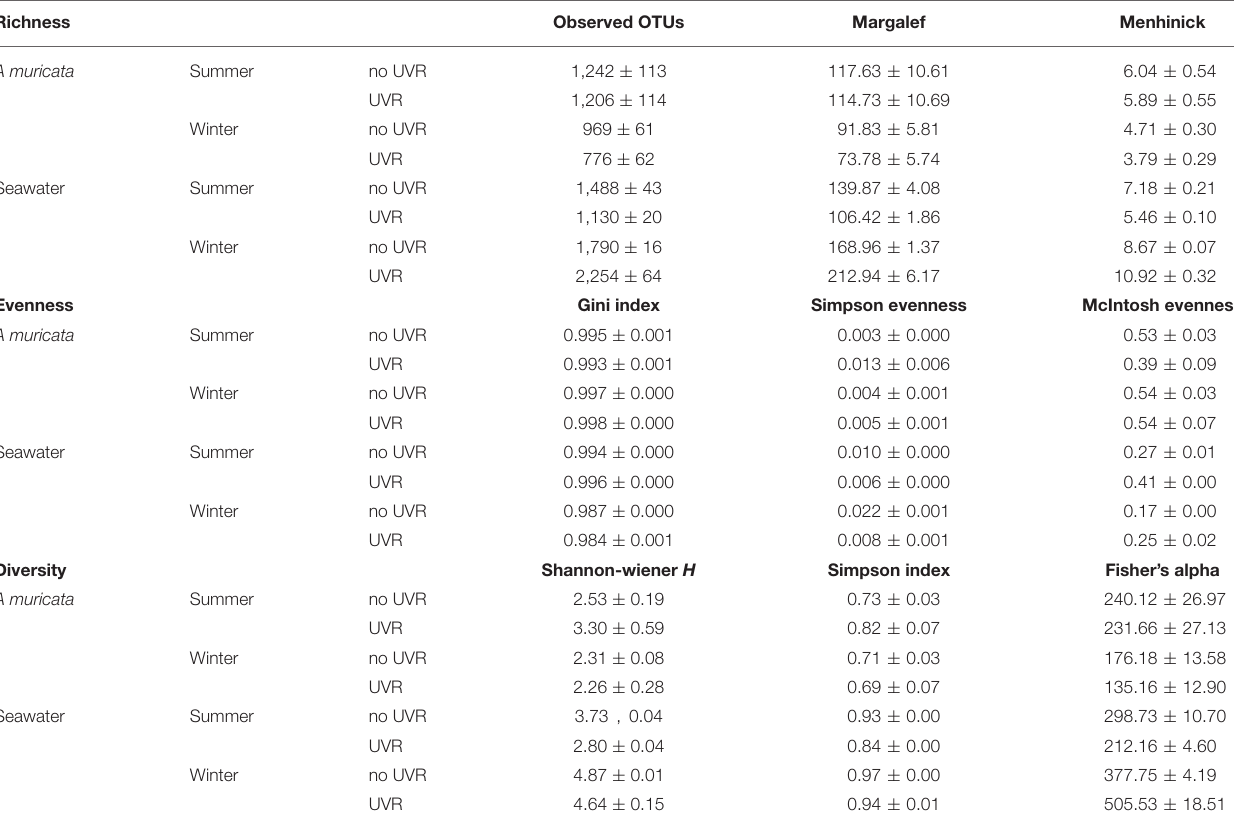
TABLE 1 | Overview of alpha diversity metrics and indices for richness, evenness, and